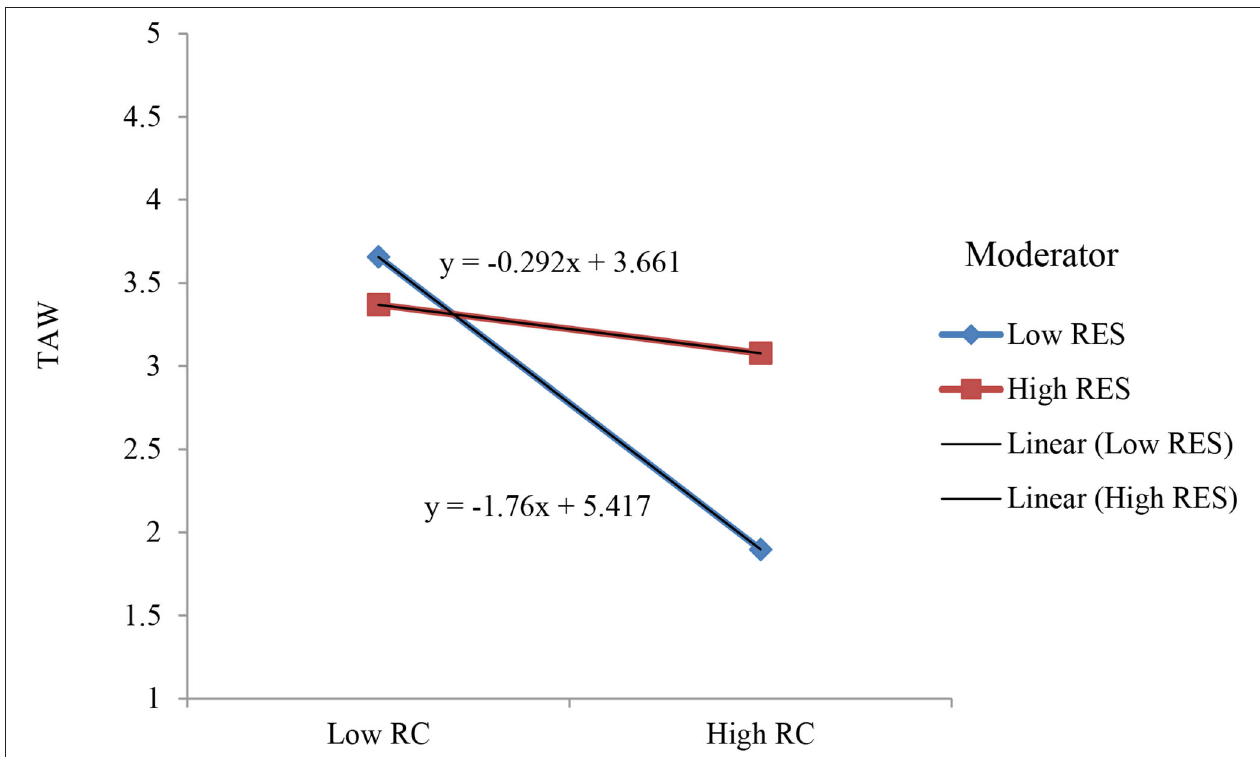
FIGURE 2 | Resilience (RES)’s moderating effect on thriving at work (TAW) through role conflict